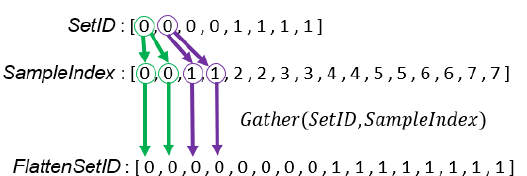
Figure 12. Illustration of creating the array which stores the corresponding set ID of FlattenSample array.